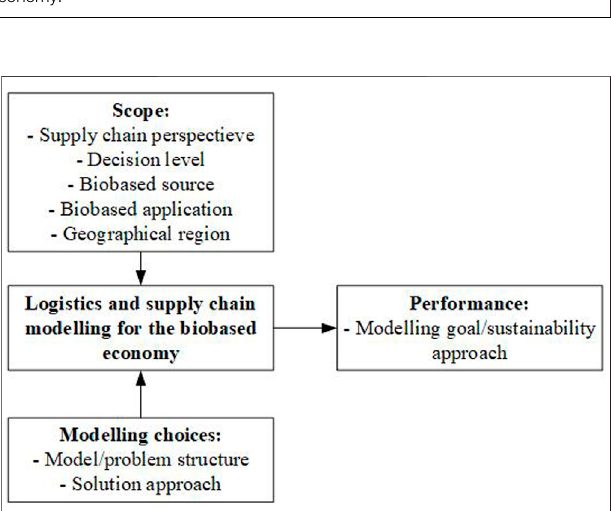
FIGURE 2 | Biobased supply chain model analytical